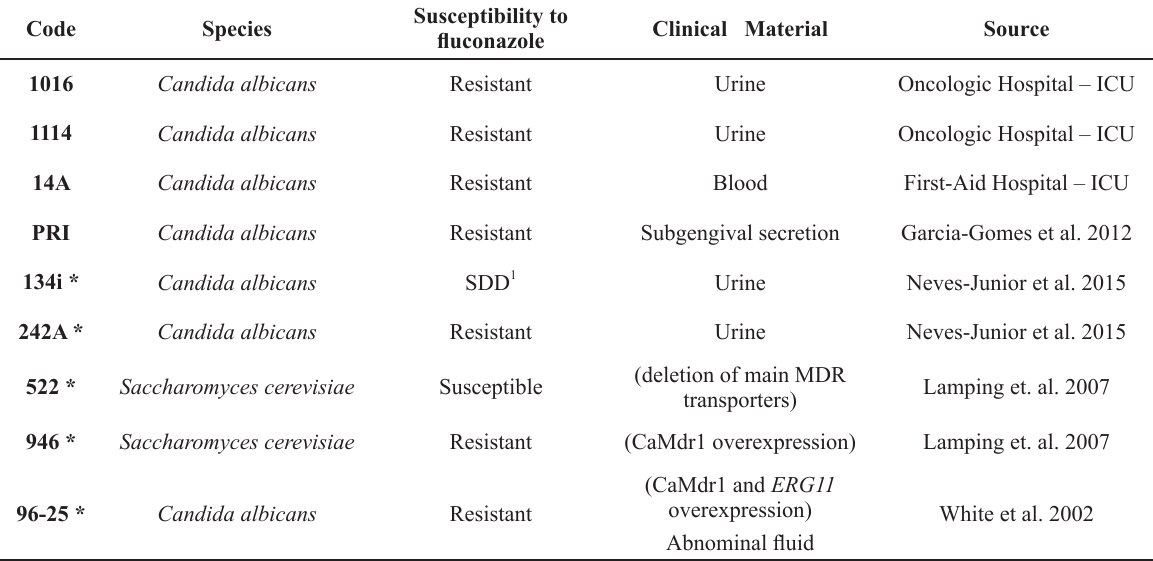
Strains used in this